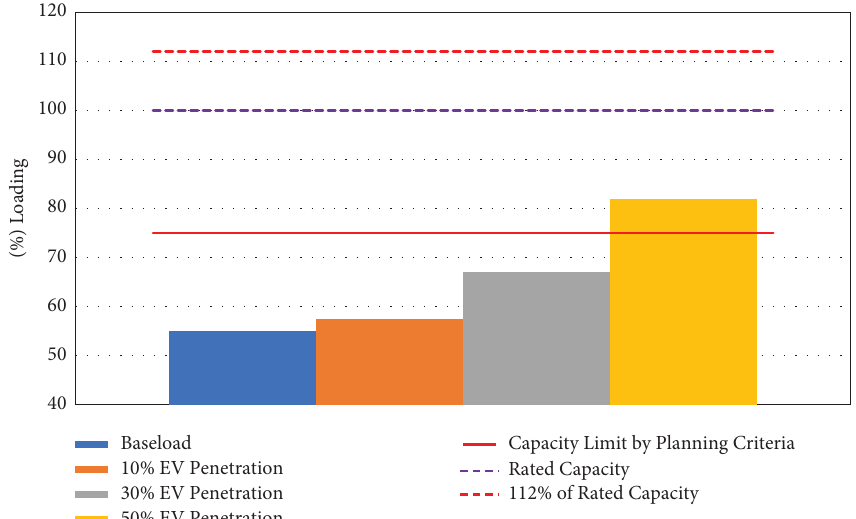
Figure 19: Percent loading of substation transformer under the three scenarios of EV penetration for uncoordinated